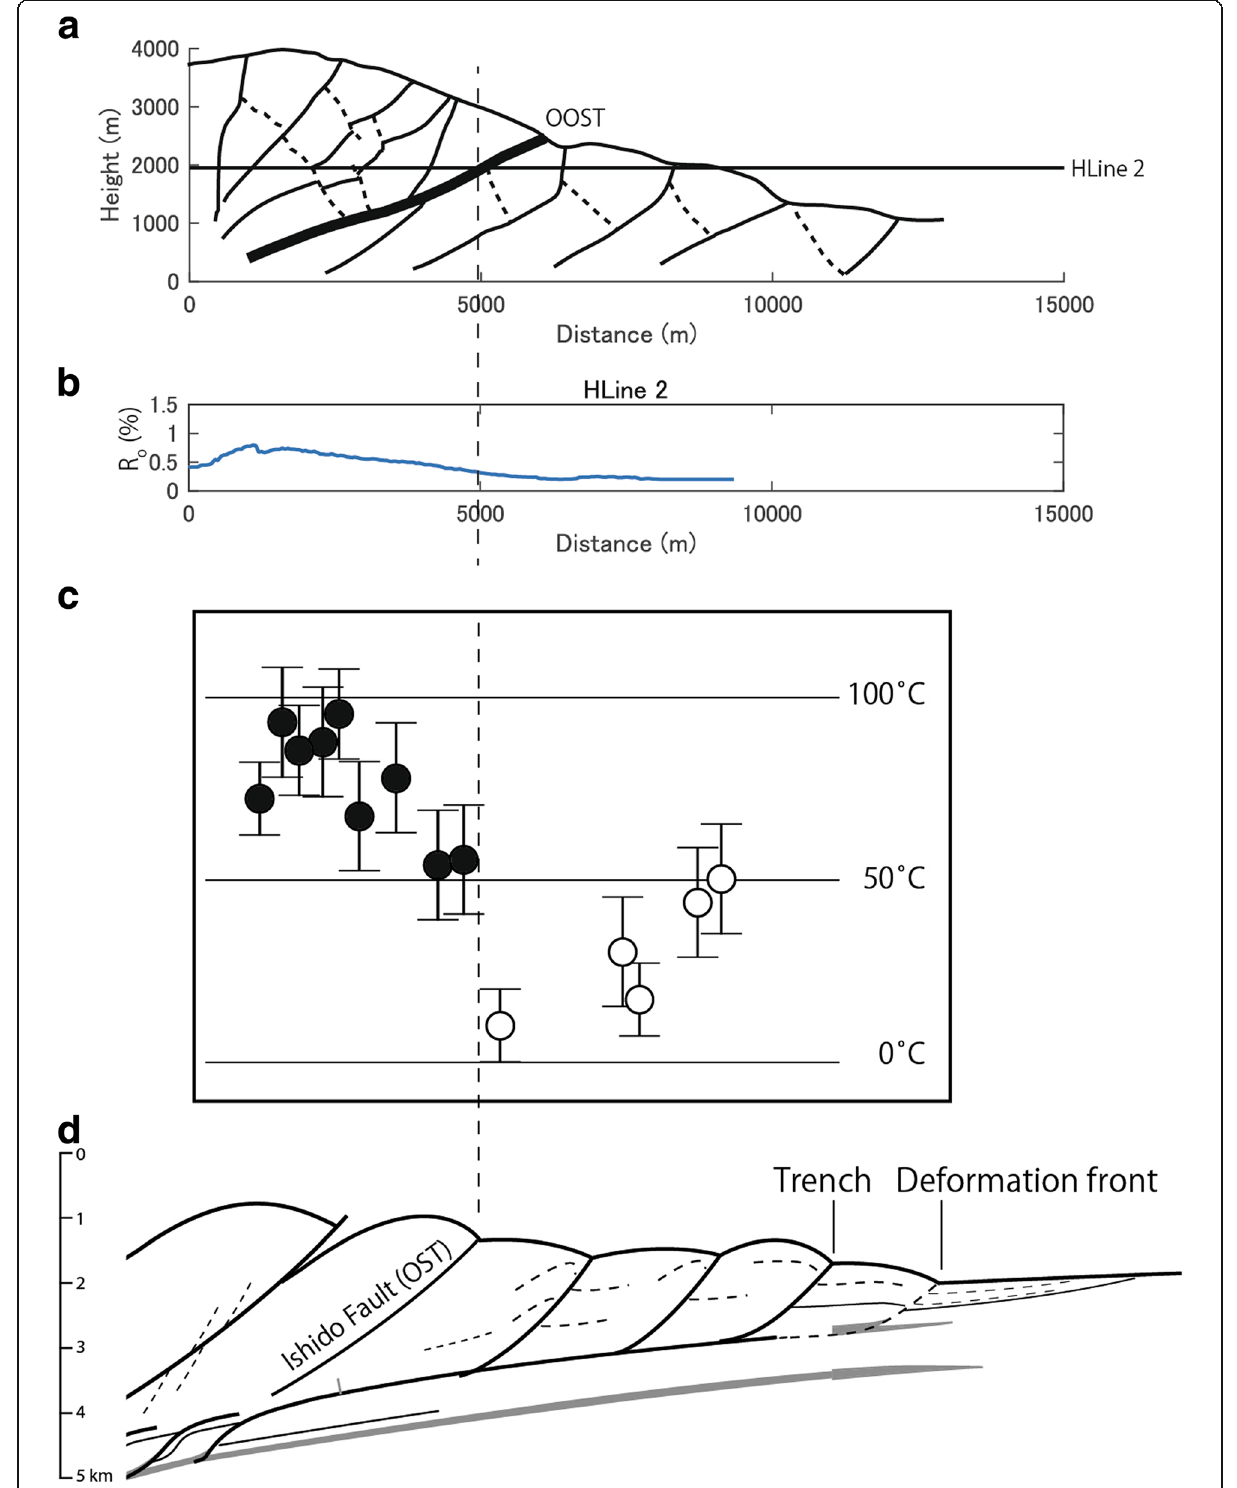
Fig. 7 A comparison of the numerical model and the natural accretionary wedge. The geological structure ( a ) and the horizontal profiles of the vitrinite reflectance ( b ) of the numerical simulation (Fig. 6). Schematic cross-section of the Miura – Boso subduction margin showing maximum paleo-temperatures deduced from the Boso Peninsula ( c , d ) (modified after Yamamoto et al.